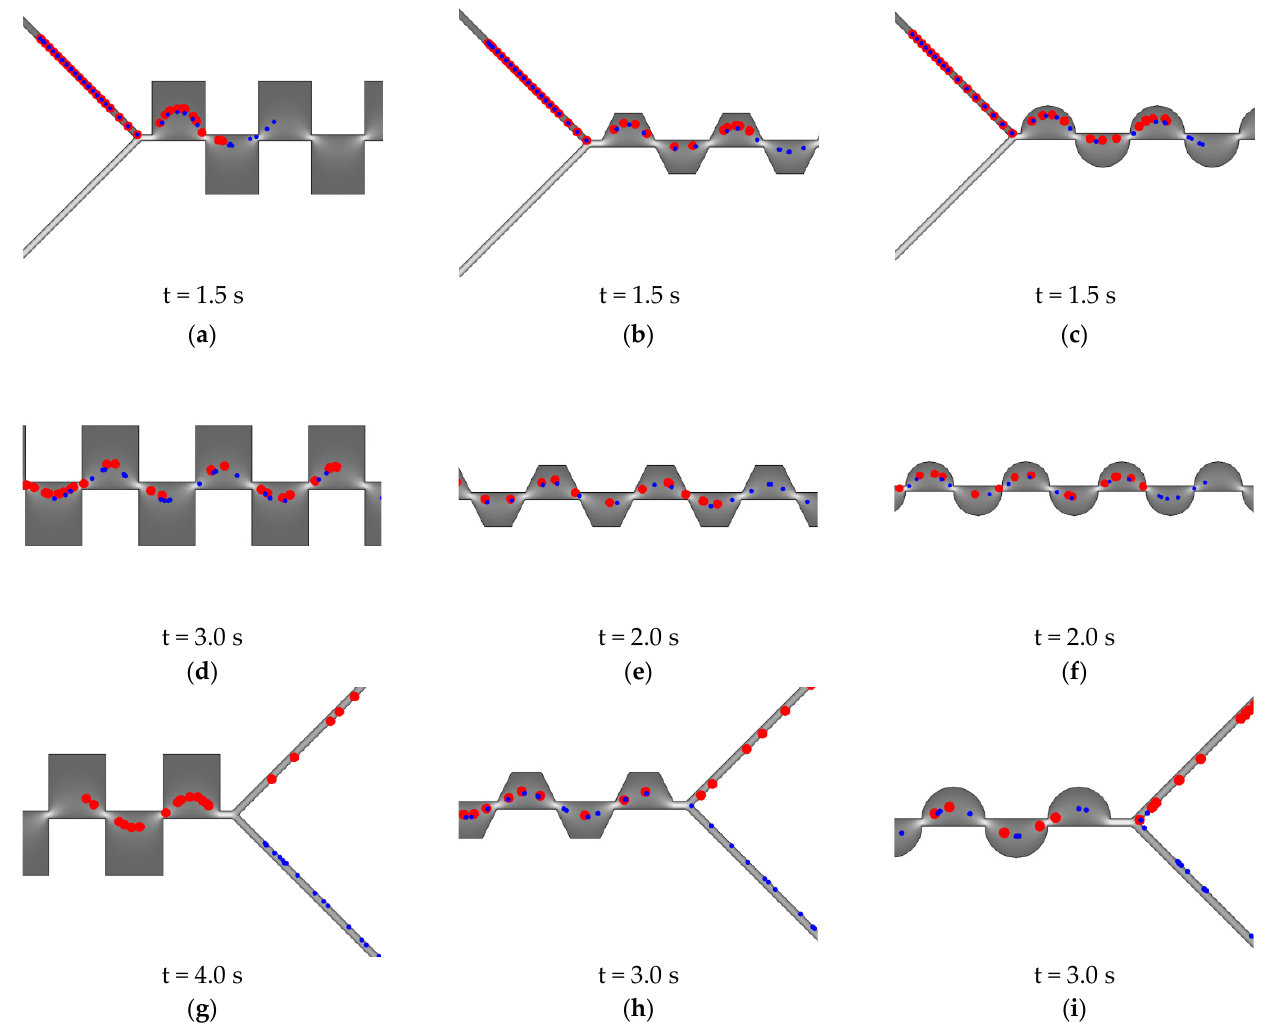
Figure 6. Particle (red: live, blue: dead) sorting for several time steps for squared ( V P = 3.2 V), trapezoidal ( V P = 3.1 V), and rounded ( V P = 0.5 V) configurations: at f = 2 MHz. ( a – c ) At the